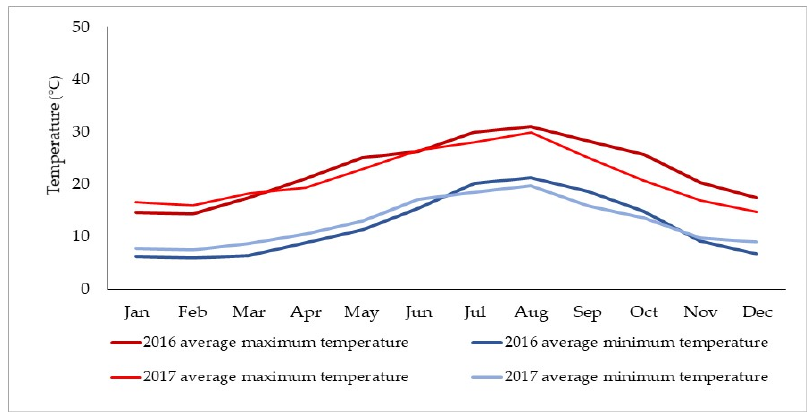
Figure 2. Maximum and minimum air temperature trends during the test period. Average air temperatures over the approx. 90 days of testing in both years increased between May and August. Maximum air temperatures were on average higher in 2016 than 2017 in May, July and August. In June, average maximum temperatures were similar in both years. Regarding minimum air temperatures, average values were highest in July and August in 2016, whilst in May and June in